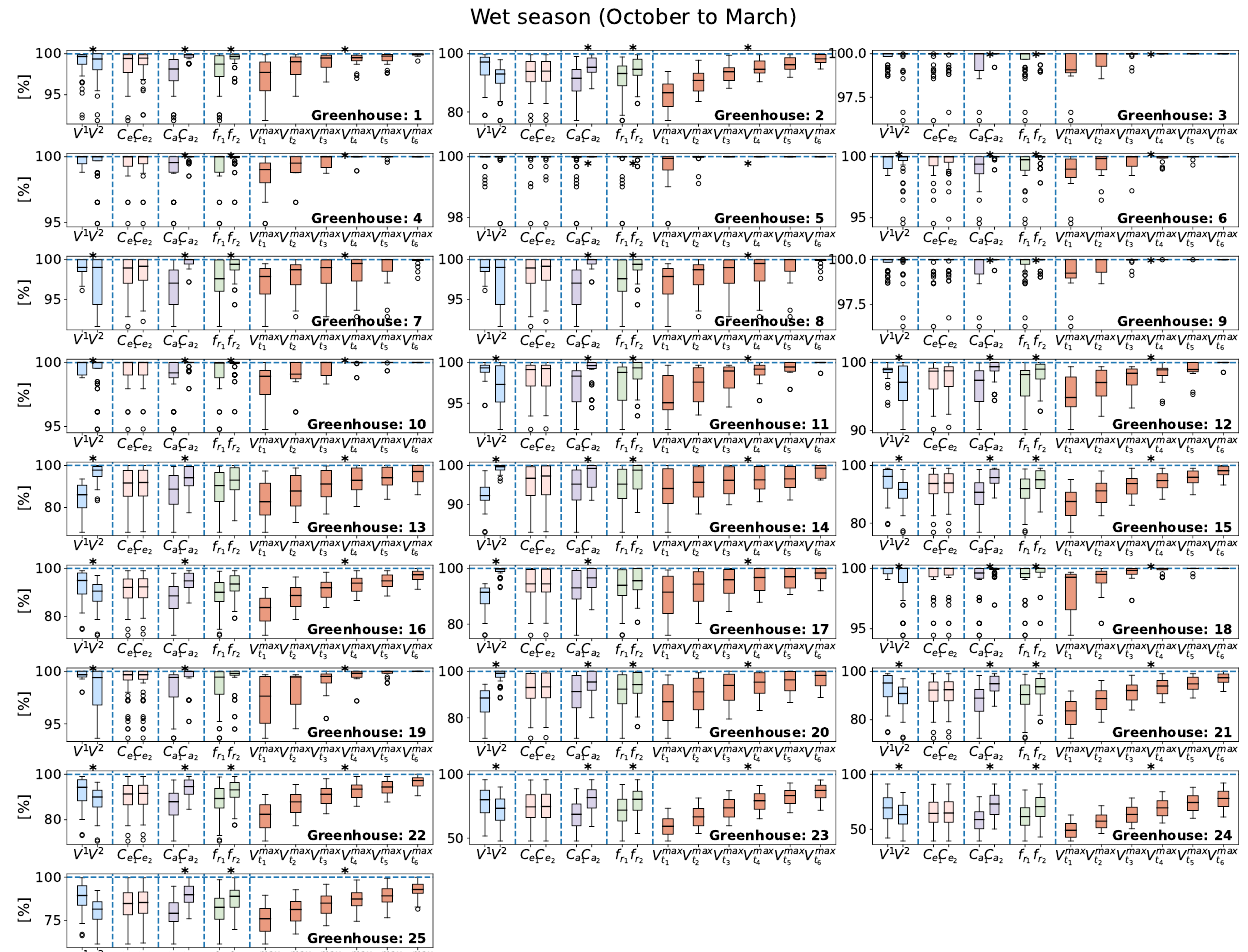
Figure 7. Box plots of the mean percentage of satisfied water demand during the wet season, October to March ( y -axis) for each greenhouse and for each parameter included in Type 1 simulations. Note that box plots reflect changes when one parameter is modified while the other remain fixed. The parameters are: 10-year time window of rainfall ( W 1 o W 2 depending on the beginning of time series, summer or winter, according to Table 2) depicted by blue boxes; the runoff coefficient = 0.8, C r = 0.9, depicted by pink boxes); the water needed for irrigation, which depends on ( C r 2 1 the number of irrigation drips and the greenhouse size, as well as on the frequency of irrigation and on the duration of each irrigation event, presenting two scenarios: larger water usage ( C a ) or 1 lower water usage ( C a ) depicted by purple boxes; the irrigation frequency, once every two days 2 = 1/2 day − 1 ) or once every three days ( f = 1/3 day − 1 ), depicted by green boxes; and the ( f i i 2 1 maximum capacity of water tanks: 300 L, 450 L, 650 L, 900 L, 1200 L, and 1600 L, depicted by orange boxes. Note that each parameter is separated by vertical dashed lines. The statistical significance of obtained values for the different set of parameters has been calculated using a t -test when we compare two factors, and through an ANOVA one-directional (F-test) when the number of factors is larger than two, which only occurs for the maximum capacity of the tank ( V max ). The black asterisks t i that sometimes appear above box plots indicate when the difference between the means is significant at 95%, i.e., p value ≤